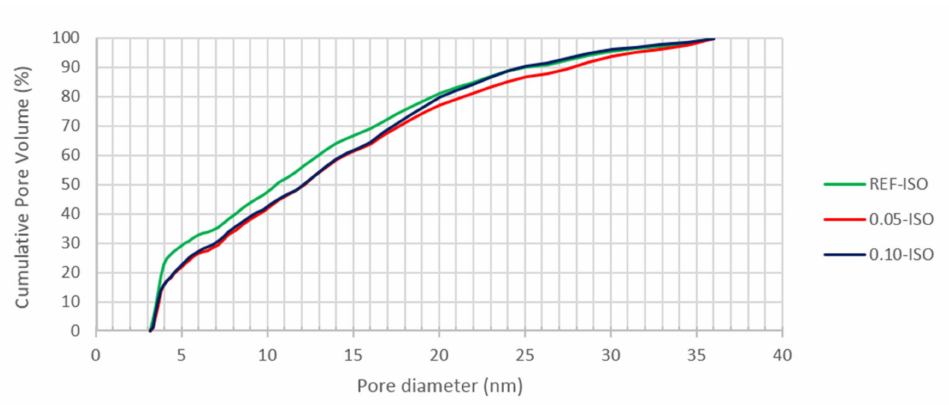
Figure 12. Cumulative pore volume of cement pastes obtained by the DFT